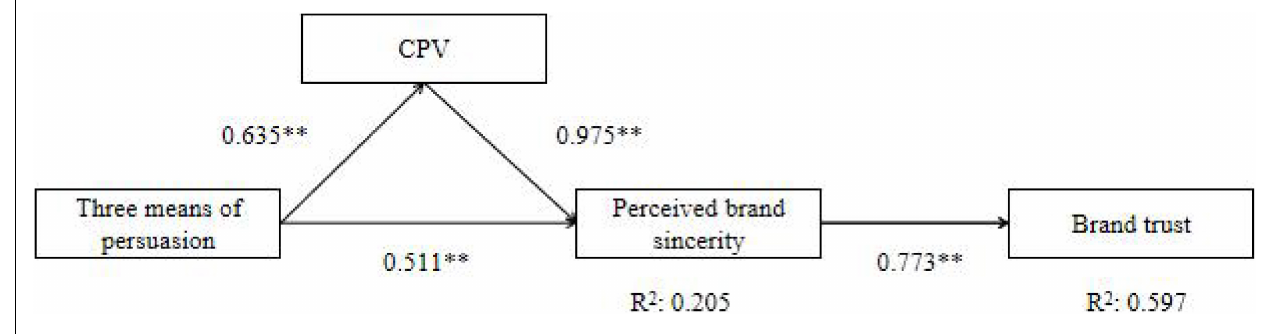
FIGURE 2 | Results of the hypothesized model. ∗∗ p < 0.01.